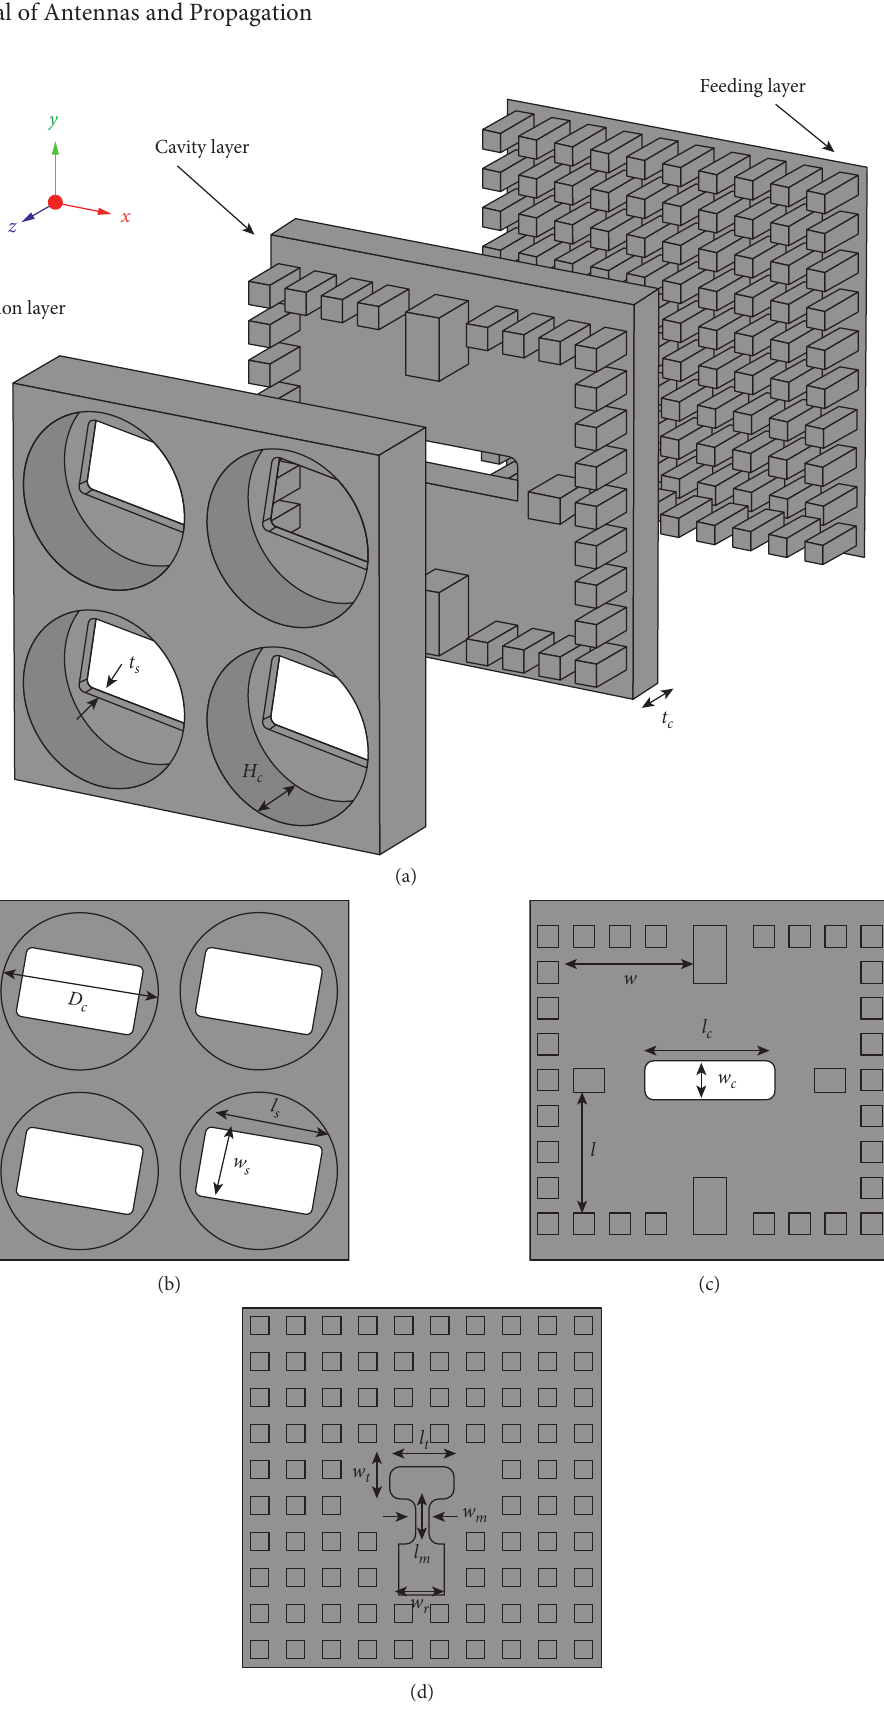
Figure 1: (a) Exploded view of a 2 × 2 cavity-backed slot subarray. (b) Radiation layer. (c) Cavity layer. (d) Feeding